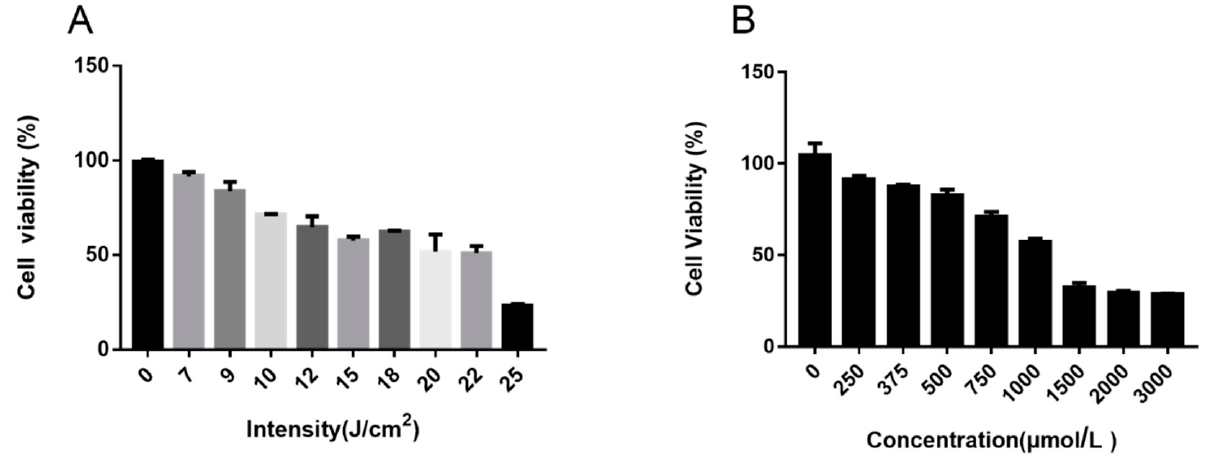
Figure 1. The toxicity of UVA ( A ) and H 2 O 2 ( B ) to HSF cells. The results are expressed as mean ± SD (n = 3). Different superscripts mean significant difference (uppercase for 24 h). There are six replicates in each group.